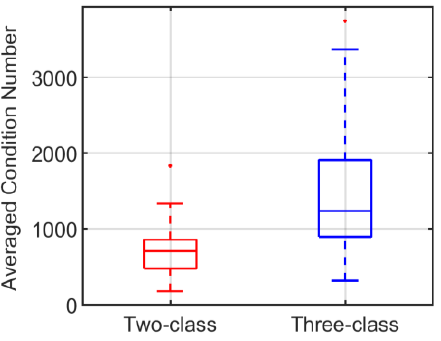
Figure 3 Averaged condition number of the 𝑫 † 𝑫 matrix for the two GLM configurations, with two or three classes, based on individual means computed with a bootstrap estimator.